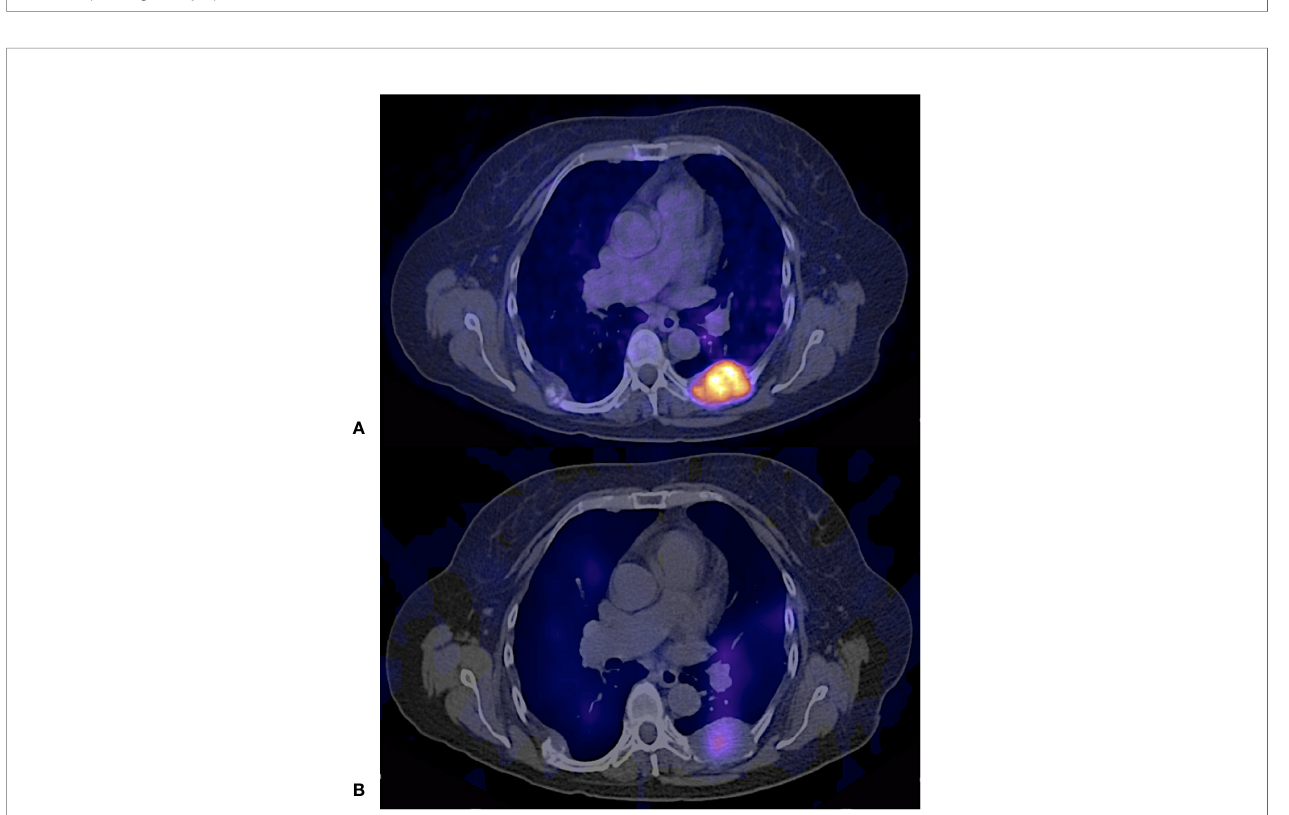
FIGURE 10 | 64 years old male, papillary thyroid carcinoma classic variant; treated with TT+RAI (cumulative dose 7400 MBq); Thyroglobulin 264.5 ng/dl. (A, B) 131 I – post therapy whole body scan shows a focal uptake in thyroid bed and difusse concentration in lungs. (C) 68 Ga – PSMA PET/CT maximum intensity projection with multiple lung and lymph node lesions PSMA avid.